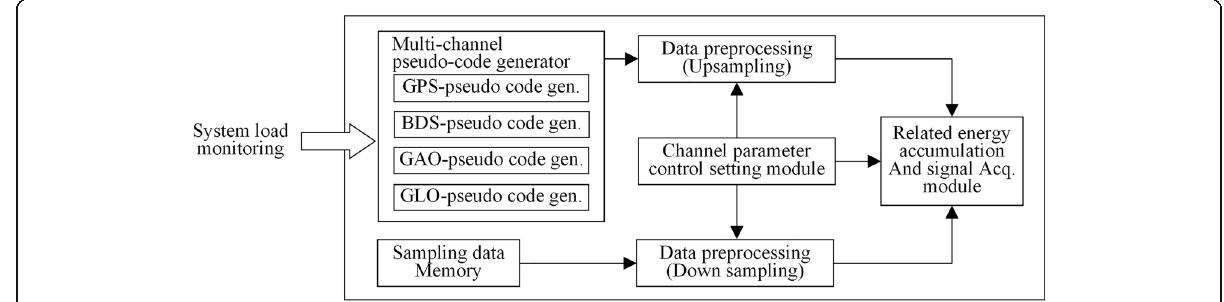
Fig. 2 The overall structure diagram of acquisition system. The figure shows the six core modules of the multi-constellation-compatible capture system and the relationship between each